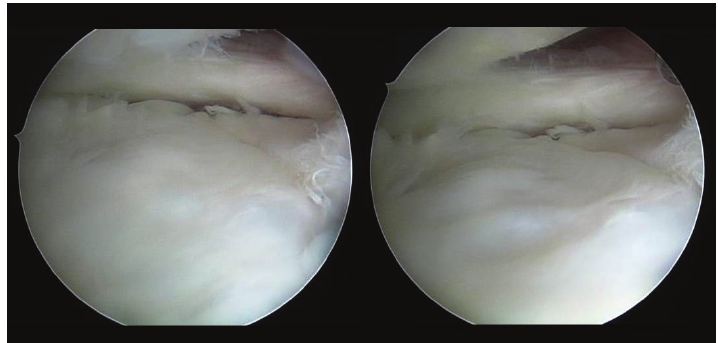
Figure 6: Arthroscopic findings 4 months postoperatively: although probing did reveal softening, the cartilage defect was completely covered with fibrous cartilage.